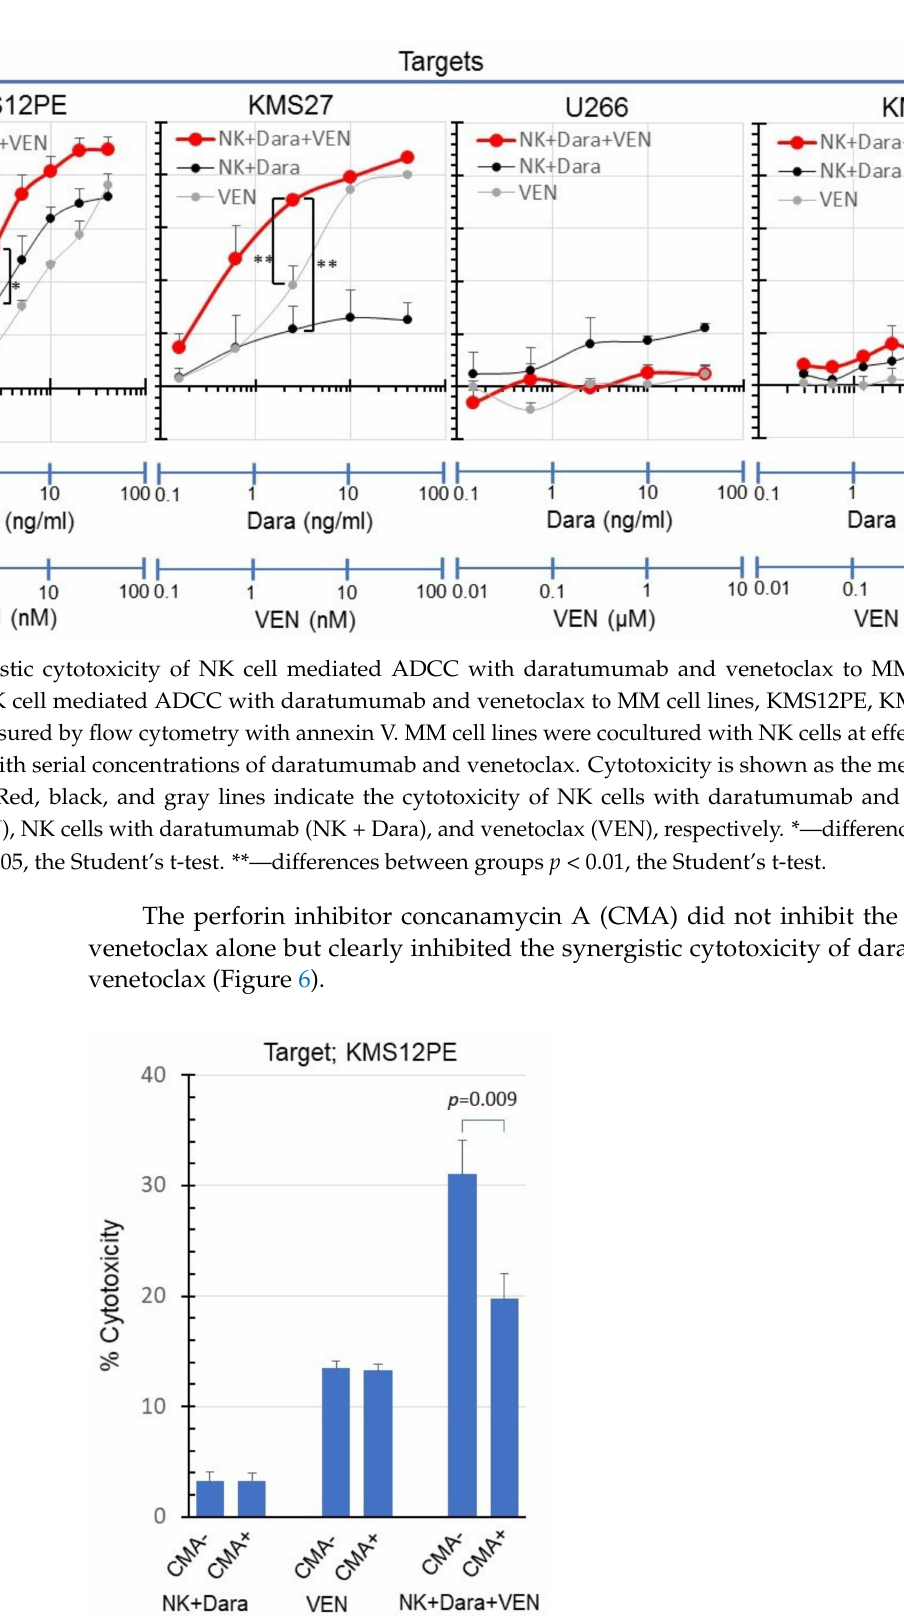
Figure 6. Inhibition of the synergistic cytotoxicity of daratumumab and venetoclax by CMA. KMS12PE was co-cultured with NK cells (E/T = 0.3), daratumumab (2.5 ng/mL), and venetoclax (2.5 nM) in the presence of CMA (10 nM) for 18